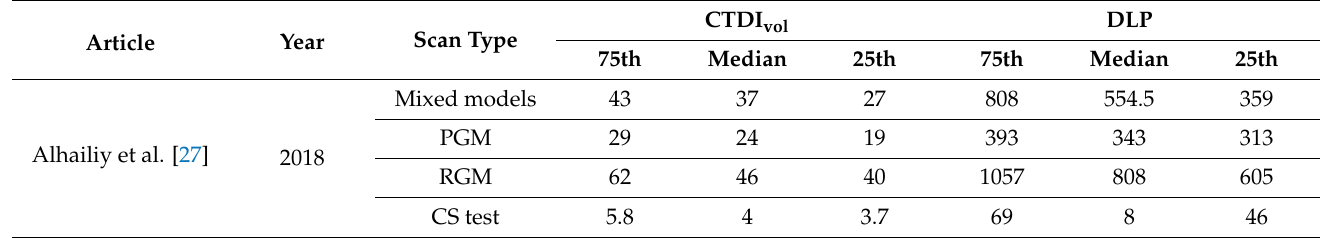
Table 5. DRLs for angiography for Coronary CT angiogram based on CTDI vol and DLP.